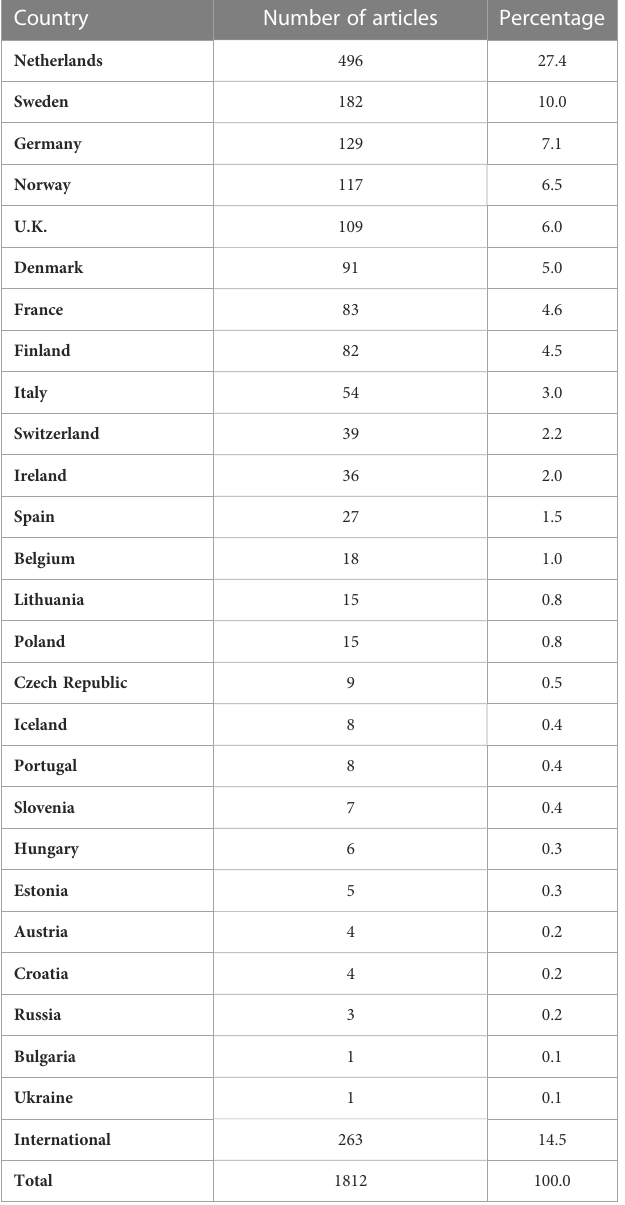
TABLE 1 Number of articles on cancer treatment by CR country of operation, January 2013-October 2022. Country Number of articles